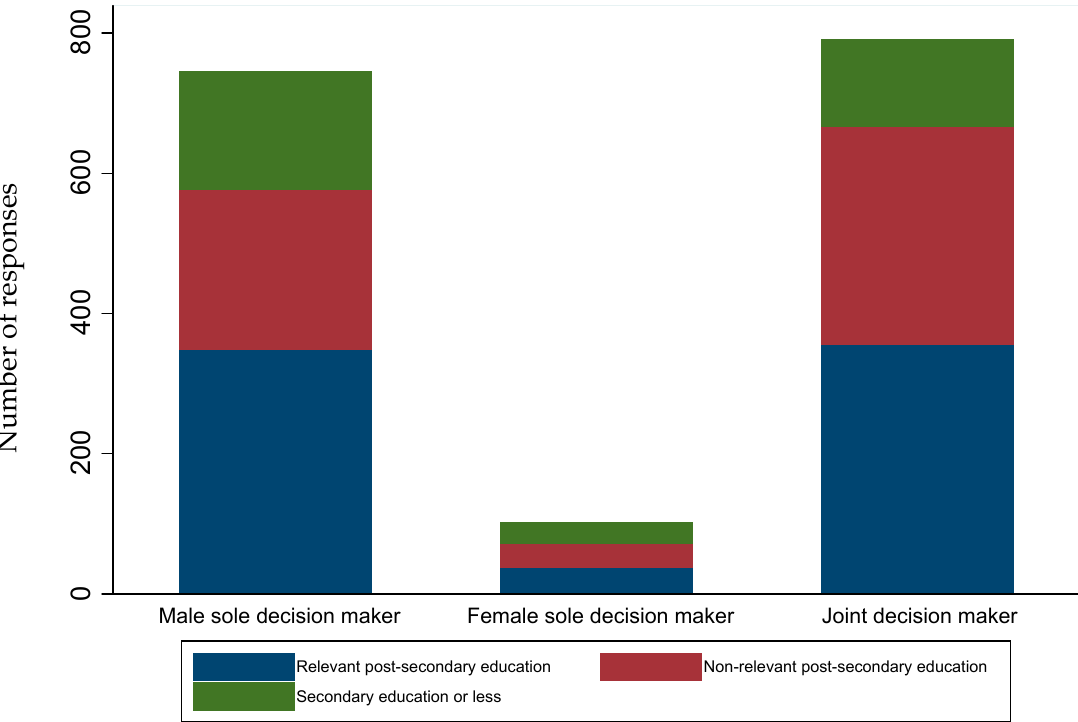
Figure 1. Field of education by gender. Notes: Relevant post-secondary education includes